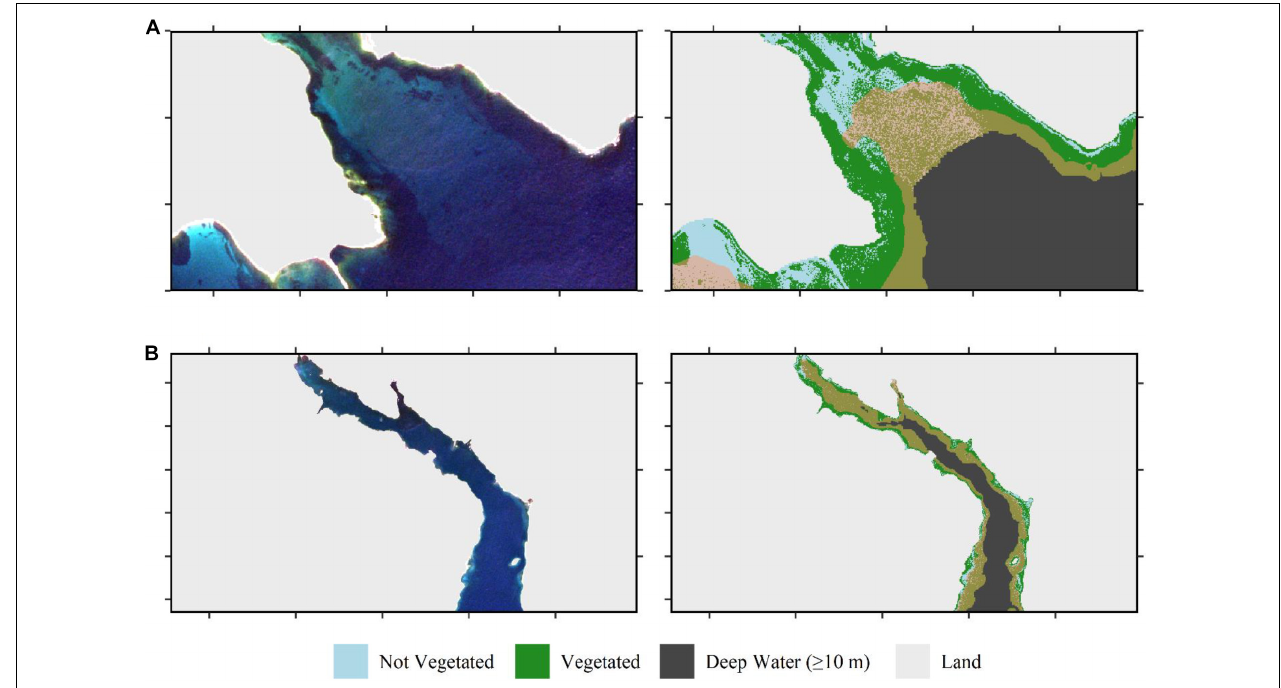
FIGURE 6 | Finalized classification of the Sentinel-2 image from September 13, 2016 highlighting variance in maximum depth the classifier was successful. Left column is the true color composite. Right column is the map classification for the same region thresholded at 80% probability of being vegetated. (A) A sandy beach at the edge of an estuary influenced by freshwater input was successfully classified to ∼ 5 m, waters at depth from 5.5 to 10 m shown with transparent yellow overlay (F6A in Figure 4 ). (B) An estuarine brackish environment by freshwater input was successfully classified to ∼ 2 m, waters at depth from 2.5 to 10 m shown with transparent yellow overlay (“brown” in the figure; F6B in Figure 4